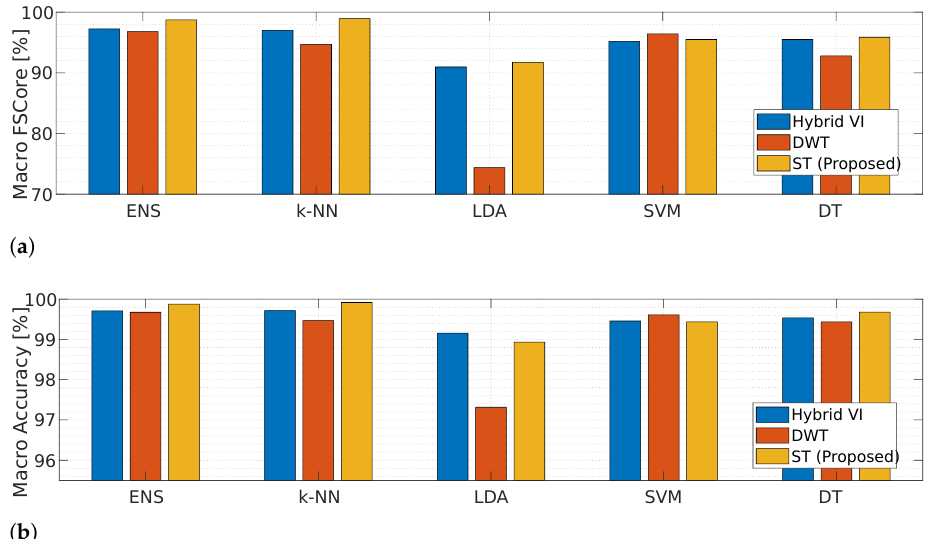
Figure 5. Average of best macro FScores and Accuracies for each classifier. ( a ) Average of best macro FScores for each Classifier. ( b ) Average of best macro Accuracies for each Classifier.